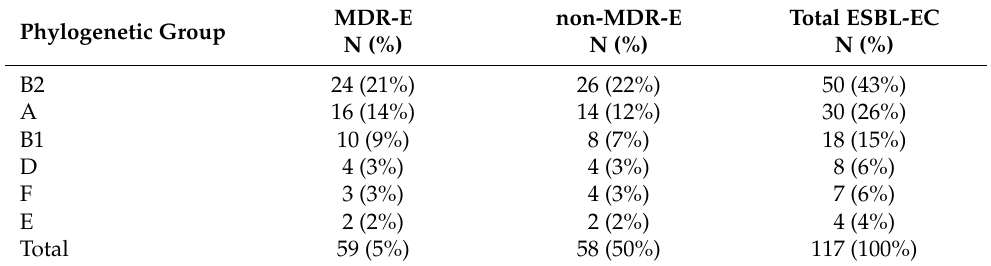
Table 3. Molecular characterization and Phylogenetic Group Assignment of